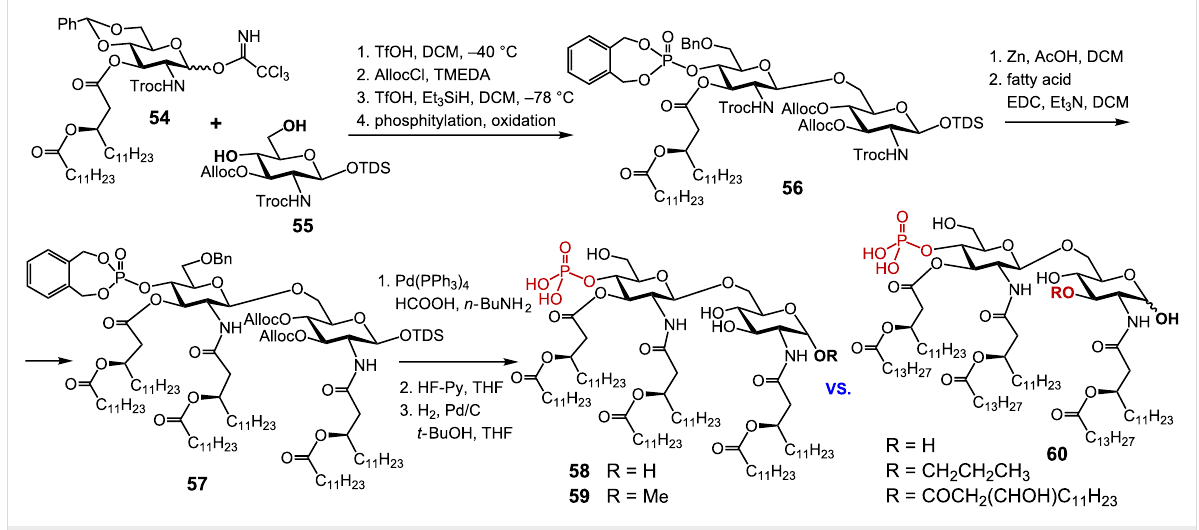
Scheme 7: Synthesis of monophosphoryl lipid A (MPLA) and